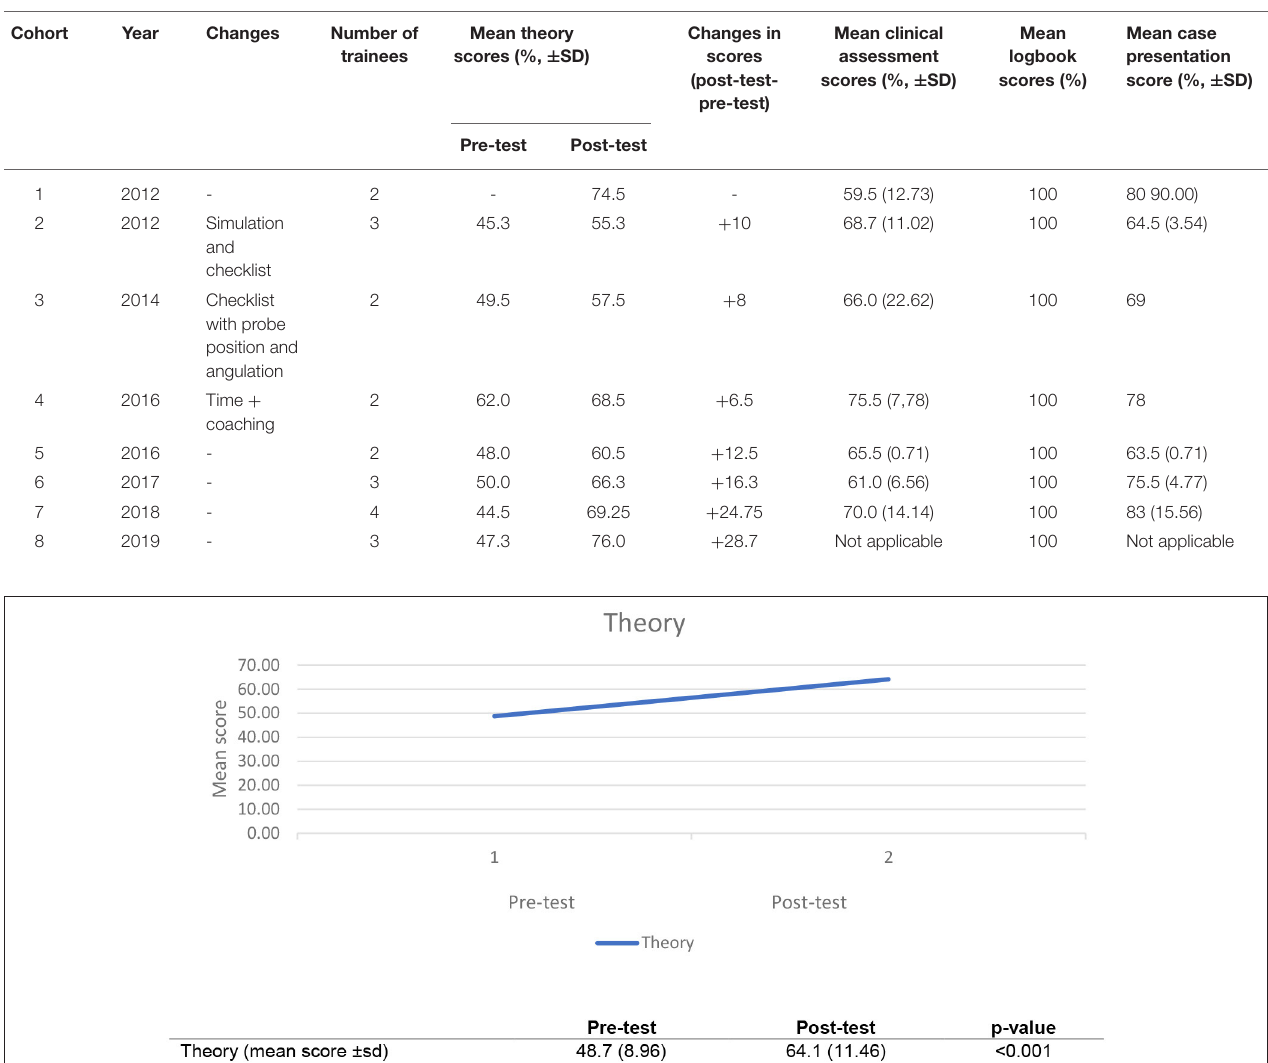
TABLE 2 | Summary of assessment scores of all the trainees, with changes in pedagogy. Cohort